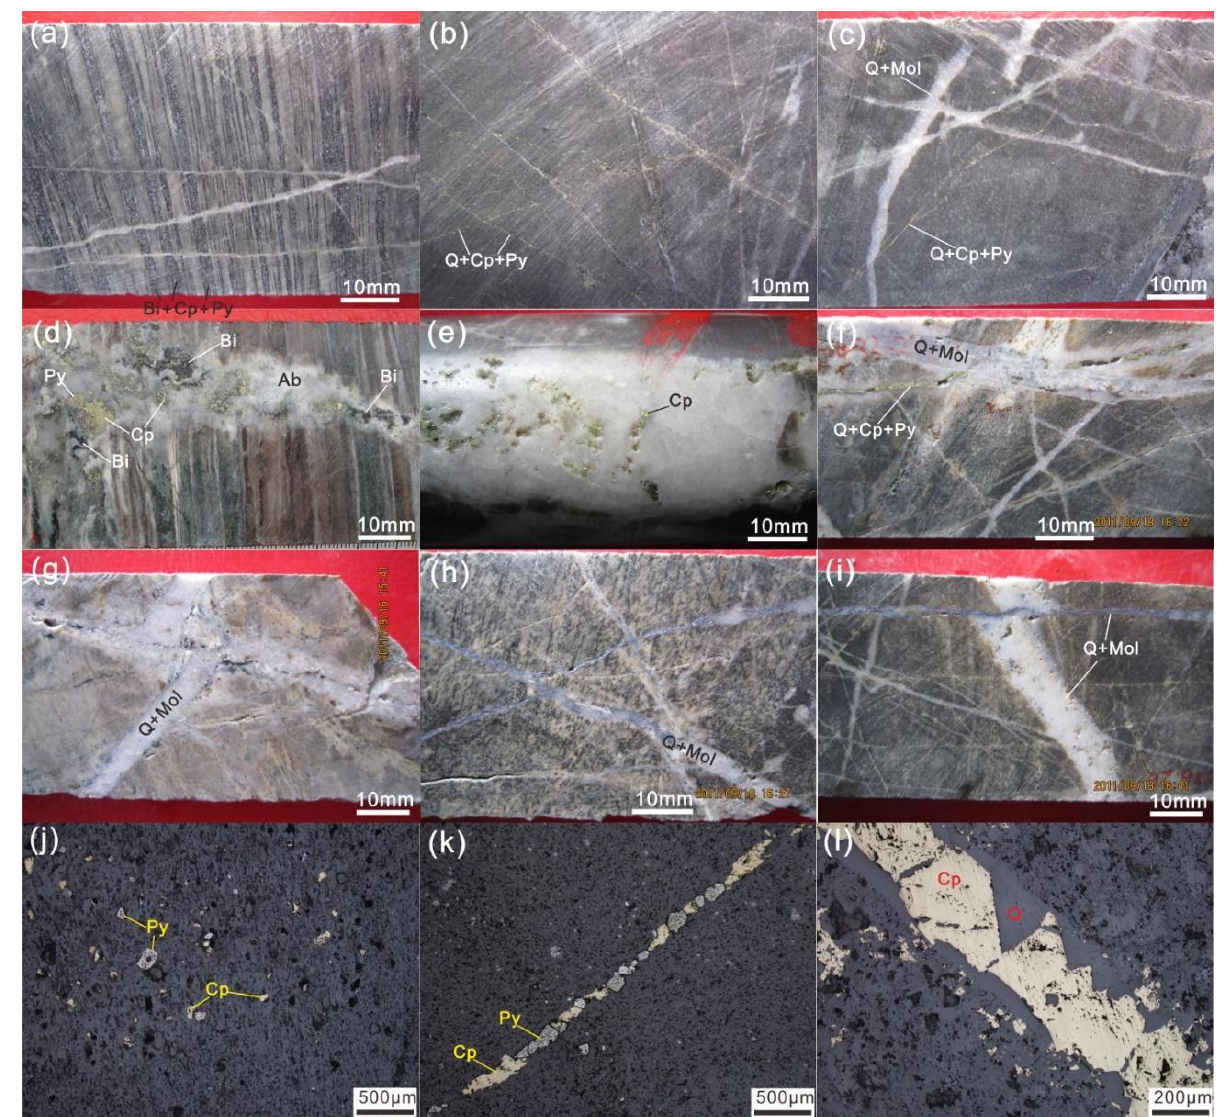
Figure 5. Photographs showing temporal relationships between the Cu and Mo stages. ( a ) Cu–I stage fine-grained